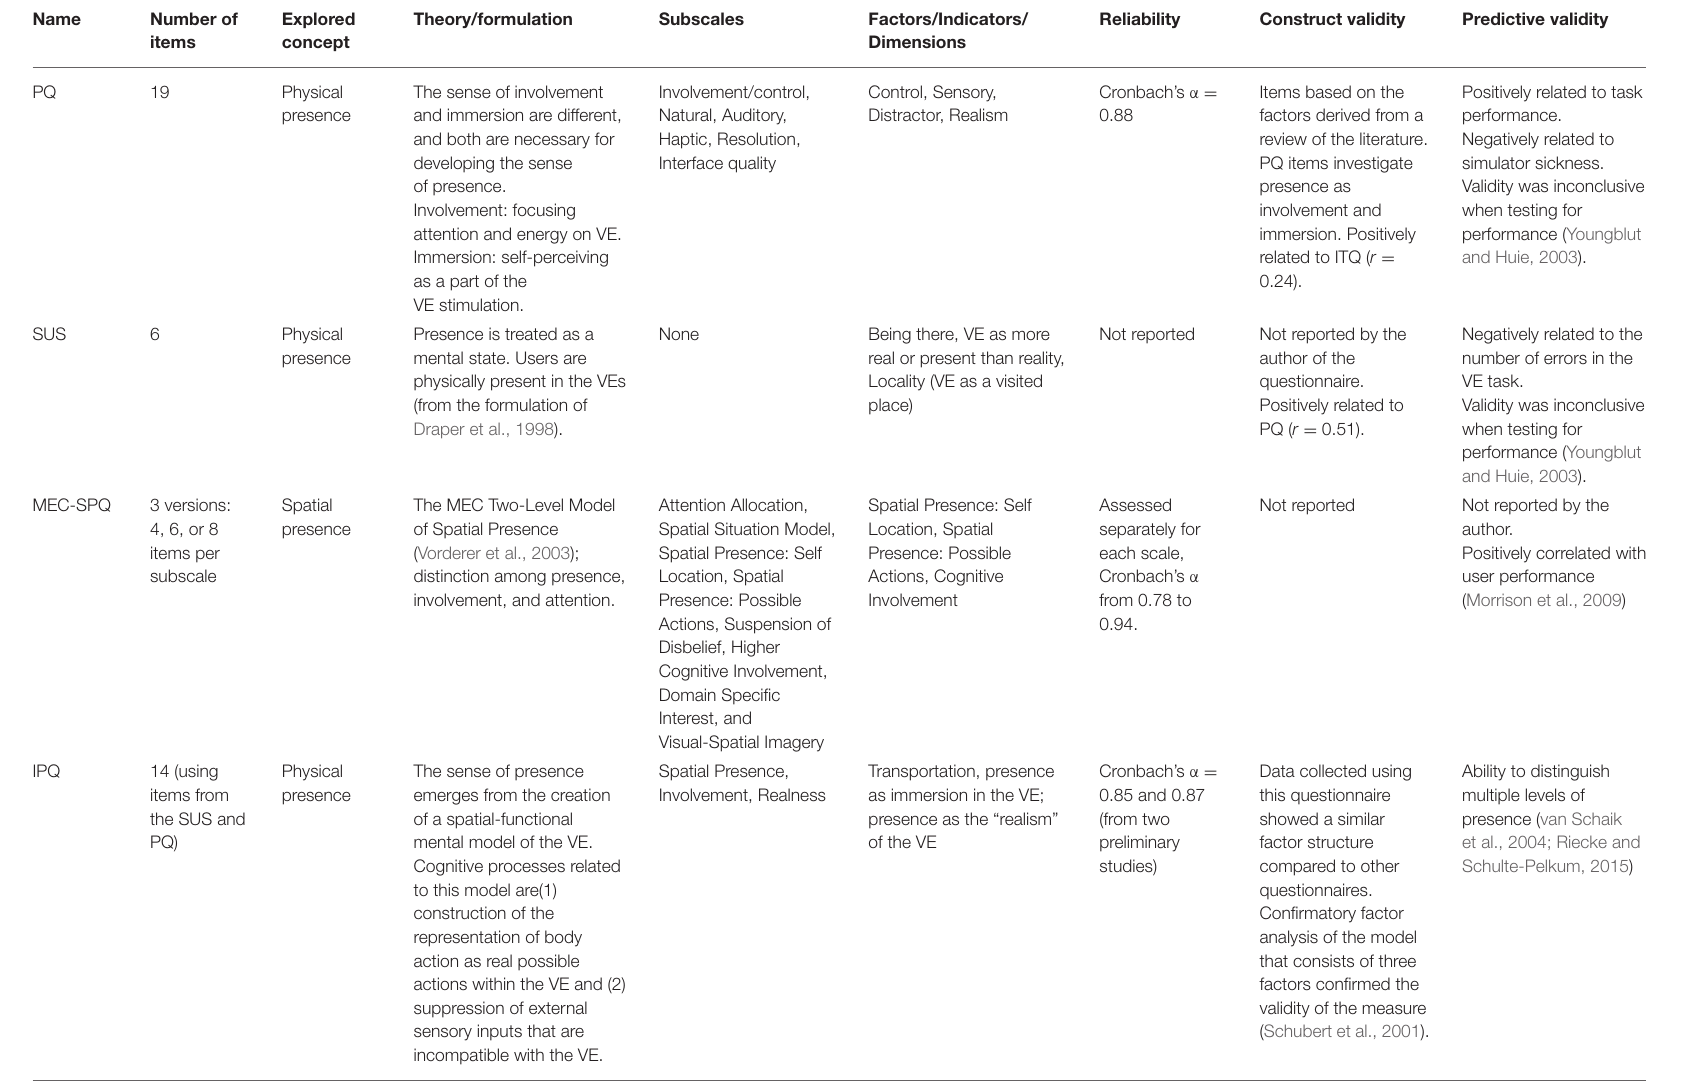
TABLE 2 | Summary of the characteristics of the most utilized questionnaires in the analyzed